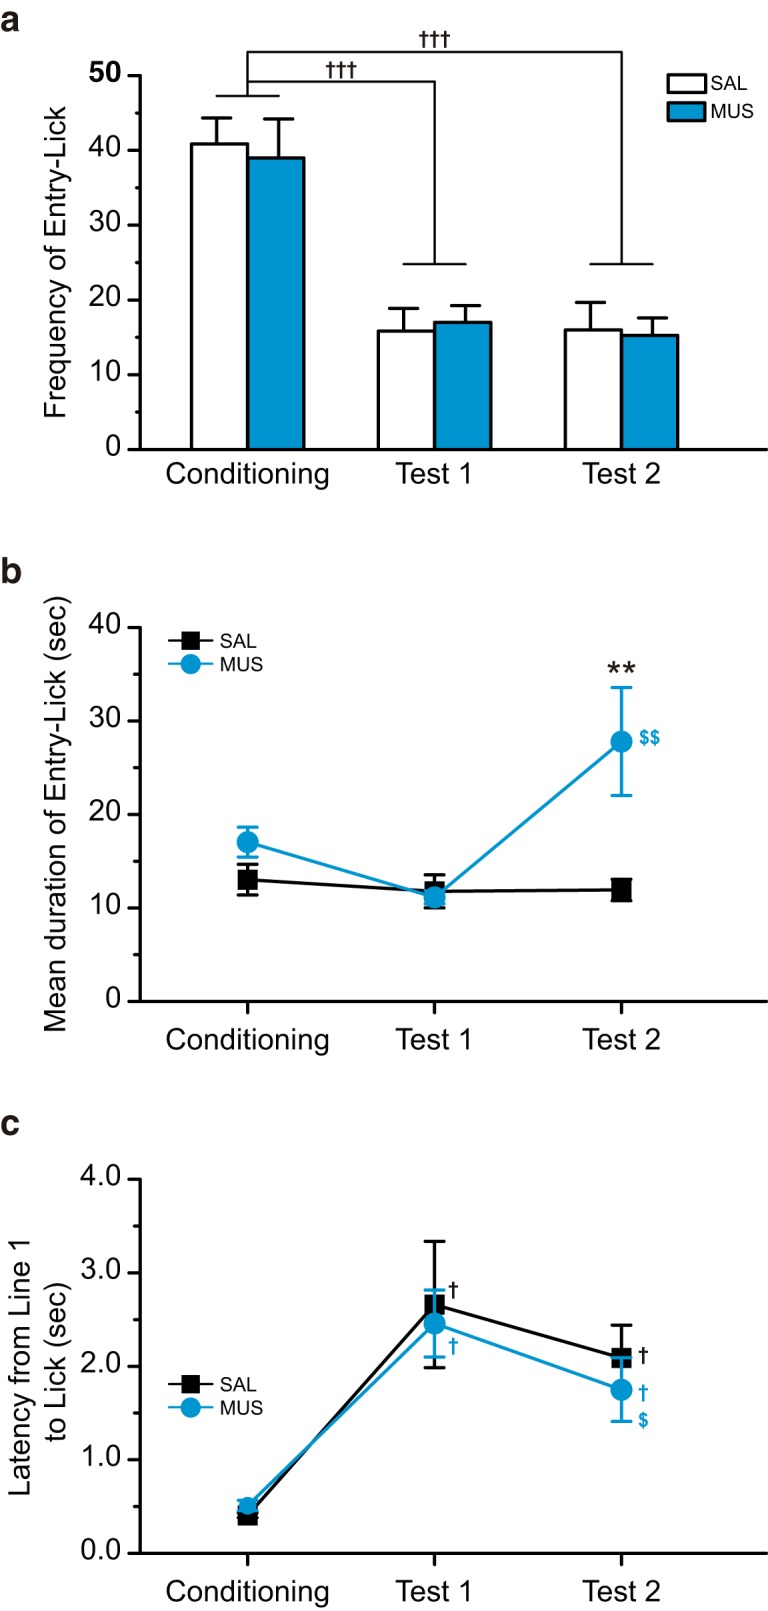
The intra-BLA muscimol decreased the mean duration of Entry-Lick. a, The frequency of Entry-Lick in the saline-injected (SAL) and muscimol-injected (MUS) groups on Conditioning, Test 1, and Test 2. The CS-US pairings considerably decreased the frequency of Entry-Lick. Both the SAL and MUS groups showed suppressed frequency of Entry-Lick on Test 2. There was no group difference. b, The mean duration of Entry-Lick. The rats showed a slightly shorter mean duration of Entry-Lick on Test 1 than Conditioning. On Test 2, the SAL group showed the same level of mean duration with Test 1, while the MUS group demonstrated significantly longer mean duration than Test 1 and the SAL group on Test 2. c, The latency from the cut of Line 1 to Lick. The CS-US pairings significantly increased latency. The microinjections of muscimol into the BLA did not alter the latency in Test 2; **p < 0.01 (vs SAL), †††p < 0.001, †p < 0.05 (vs Conditioning), $$p < 0.01, $p < 0.05 (vs Test 1).